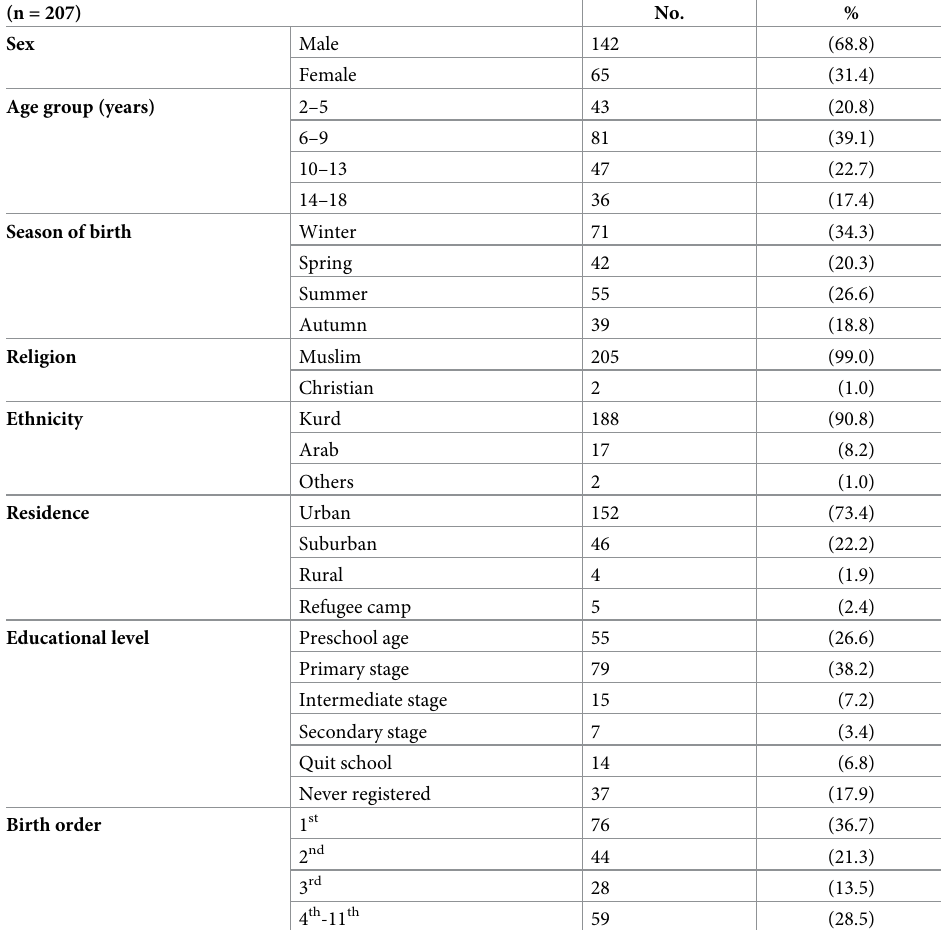
Table 1. Sociodemographic characteristics (individual